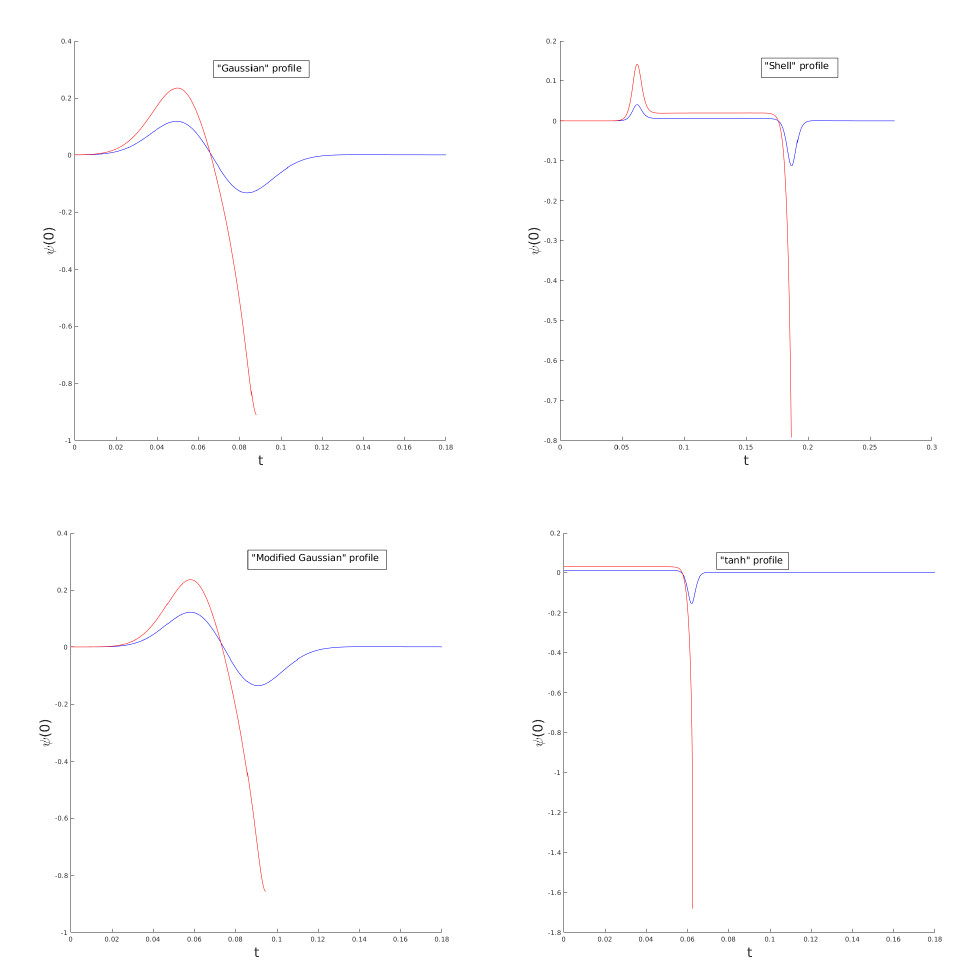
(cid:112) Figure 1: Plot of ψ ( 0 ) ≡ φ ( t ,0 ) / 8 π vs. t for some representative profiles. We have plotted a representative collapsing (ie., super-critical) case and a dispersing (ie., sub- critical) case of the same profile in red and blue respectively. The sub-critical cases start exhibiting large field movement as they get close to criticality, but otherwise their field movement is hierarchically smaller than O ( 1 ) . All super-critical cases ex- hibit ∼ O ( 1 ) field range. We have checked that the Einstein constraints are satisfied (within small numerical error) for every point shown in the